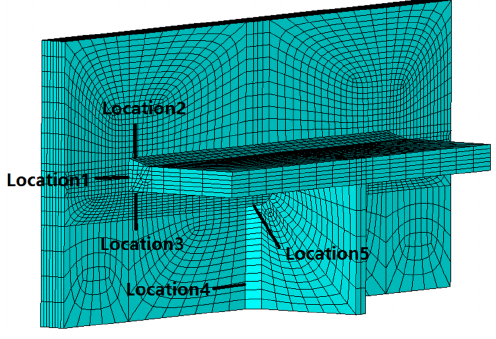
Figure 9. Five typical locations.